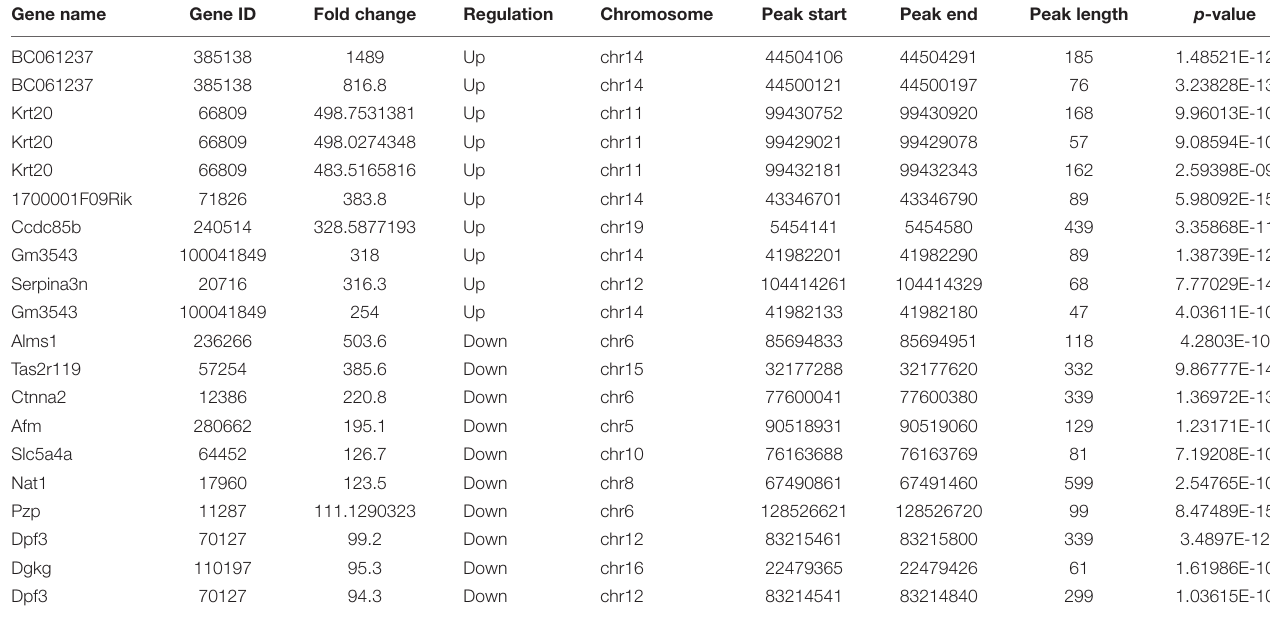
TABLE 1 | The top 20 differently methylated m6A peaks in